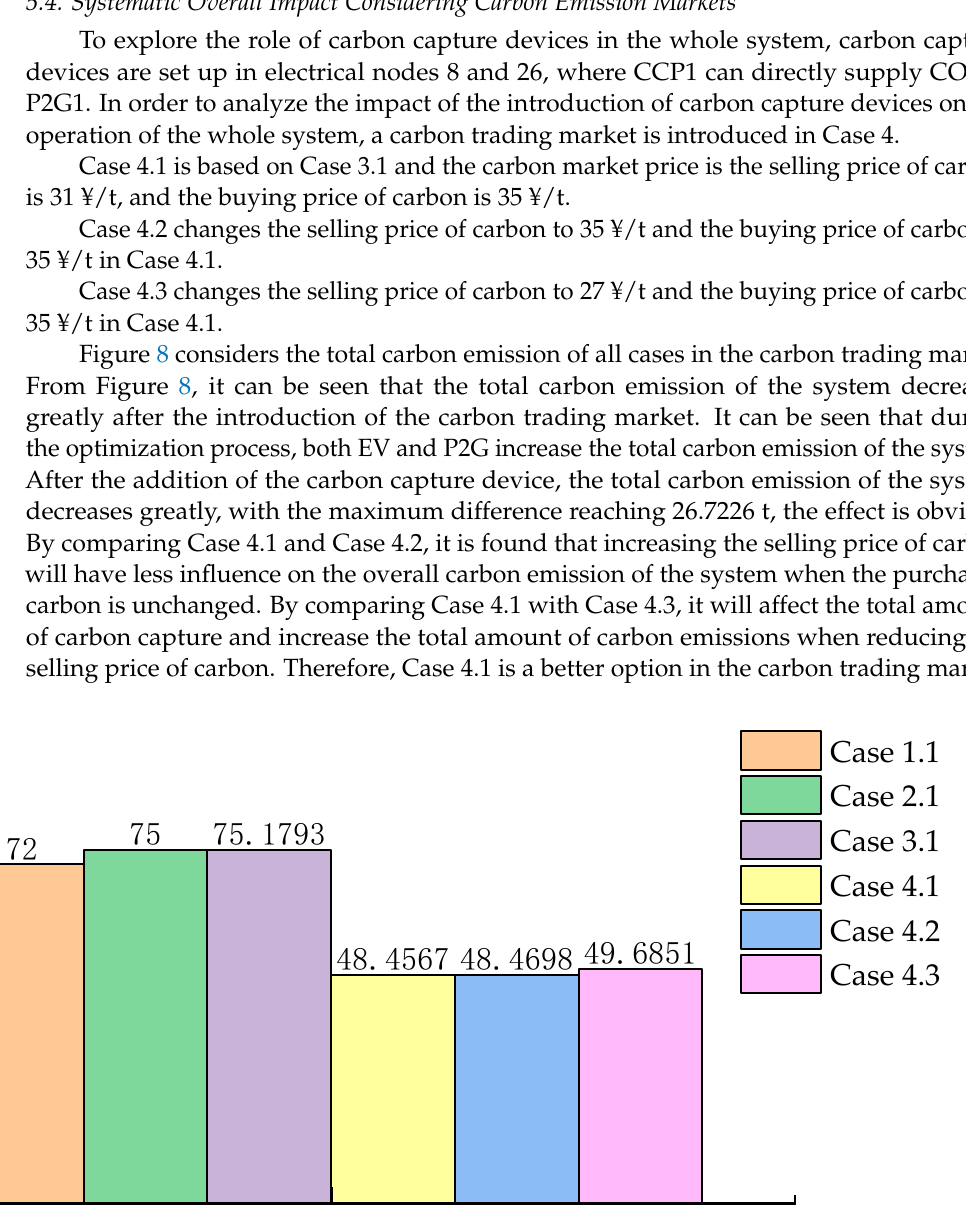
Table 4. The different cost between Case 4.x.